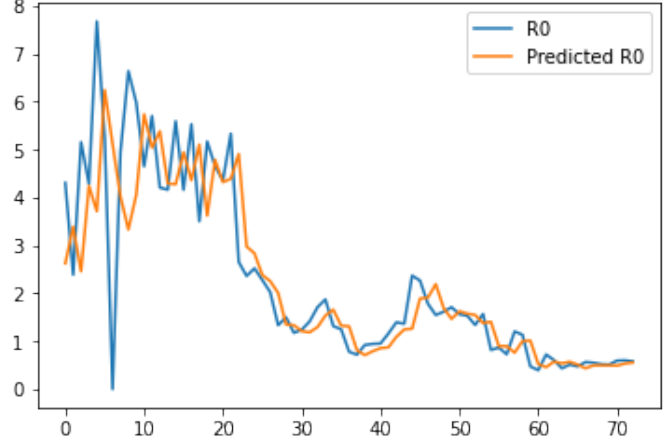
Figure 2. R 0 rates during given the